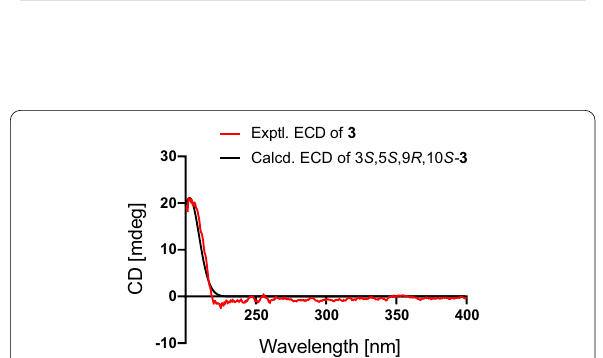
Fig. 7 Experimental and calculated ECD spectra of compound